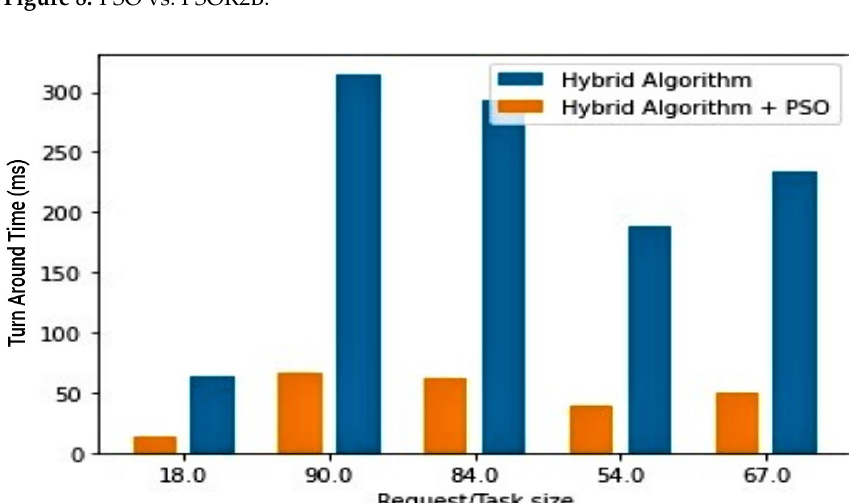
Figure 9. Hybrid vs. PSOR2B